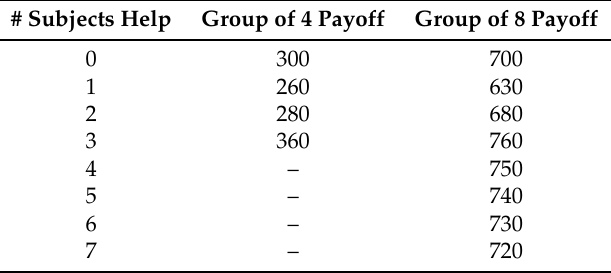
Table A11. Helping game: group payoffs.